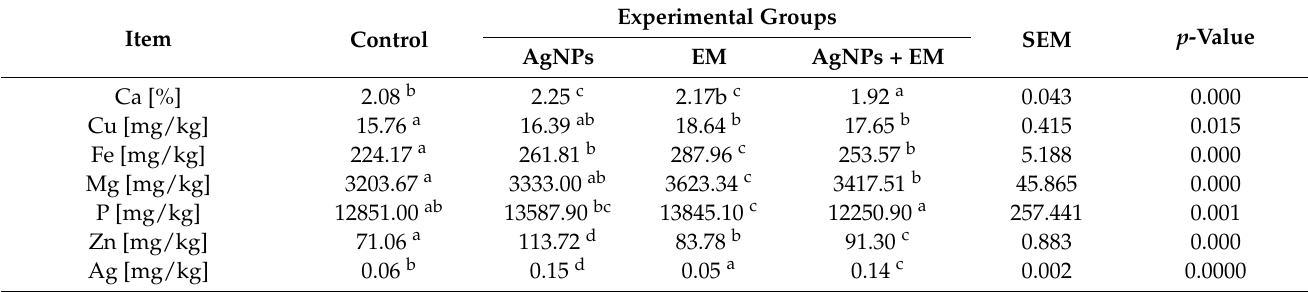
Table 2. The mineral content of snail carcasses (in dry matter) in the control and experimental